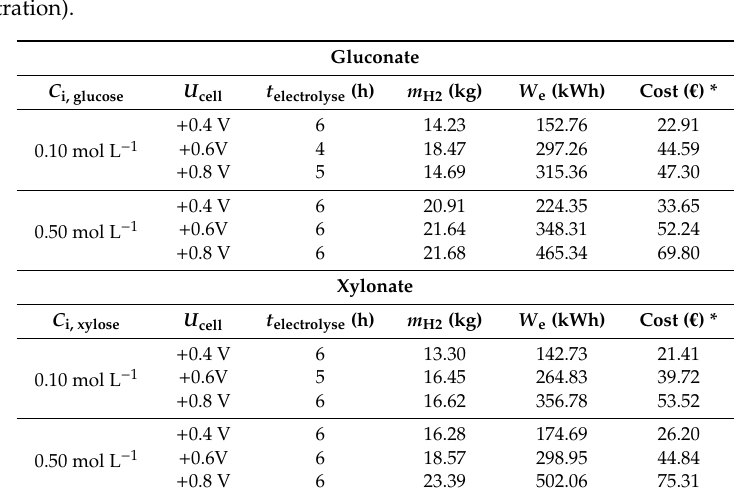
Table 4. Amount of hydrogen concomitantly produced electrical energy consumed and cost related to the electric energy consumption to produce 1 ton of gluconate / xylonate using the best configurations of Tables 2 and 3 (the highest production of gluconate and xylonate at each cell voltage and each